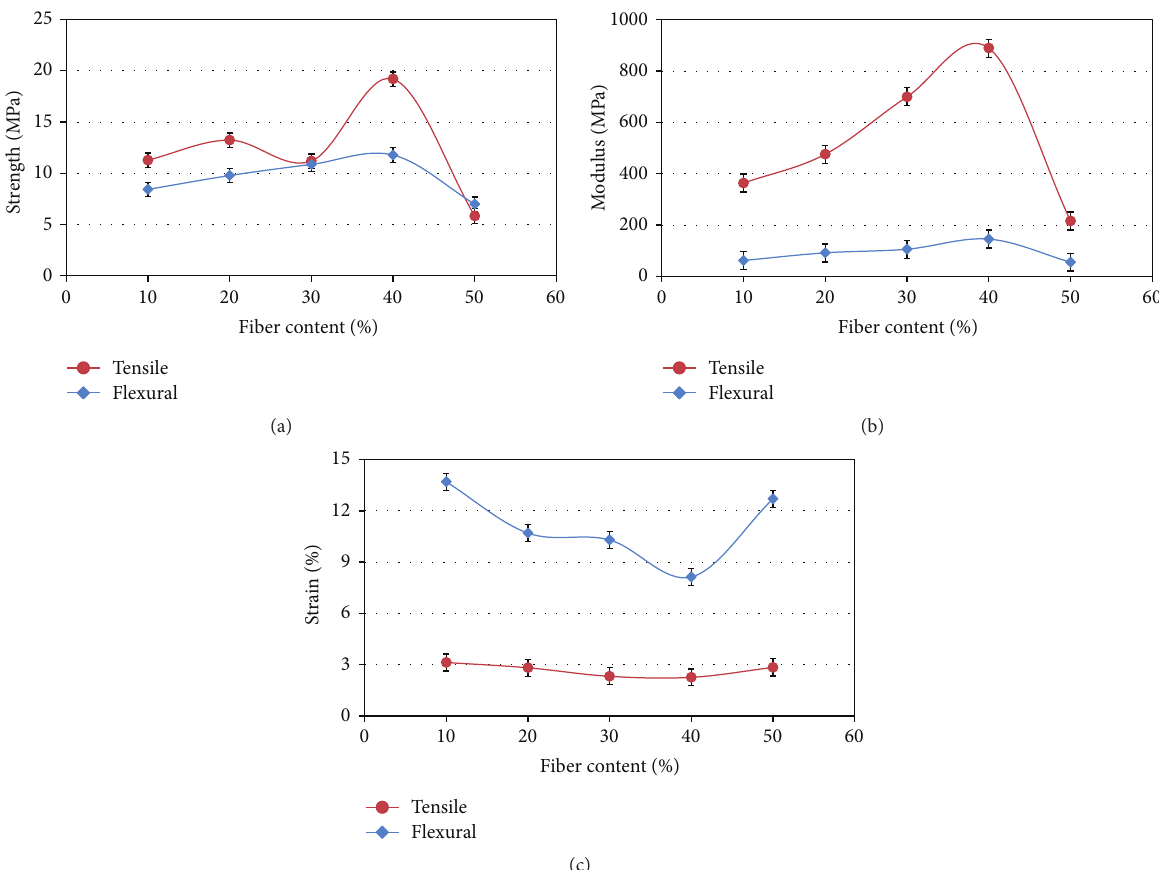
Figure 5: Comparison of (a) tensile and flexural strength with kenaf fiber content, (b) tensile and flexural modulus with kenaf fiber content, and (c) tensile and flexural strain with kenaf fiber content.